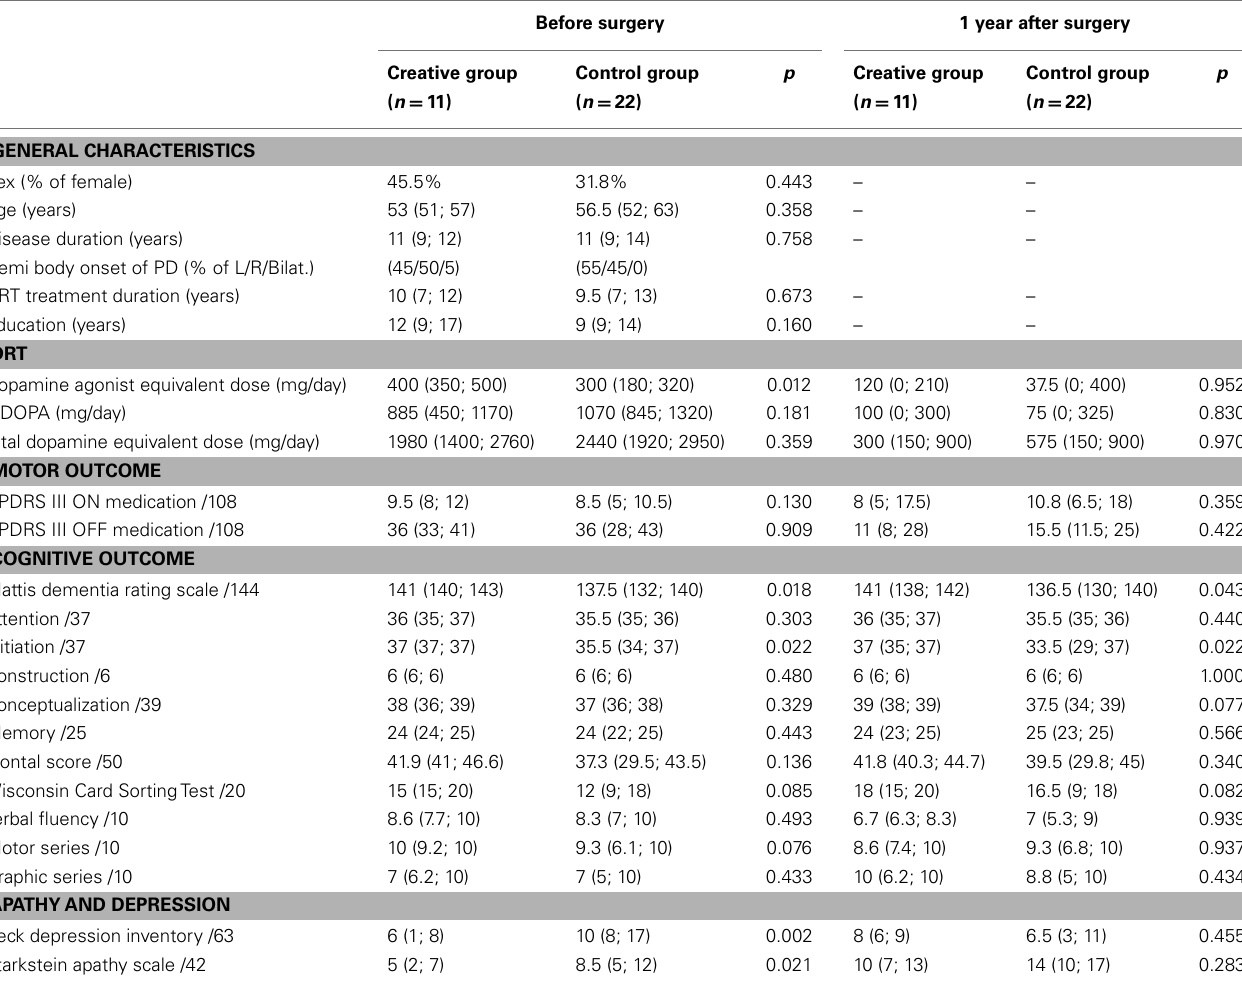
Table 1 | Patients’ characteristics before and 1 year after surgery, expressed by median (25th; 75th percentile).